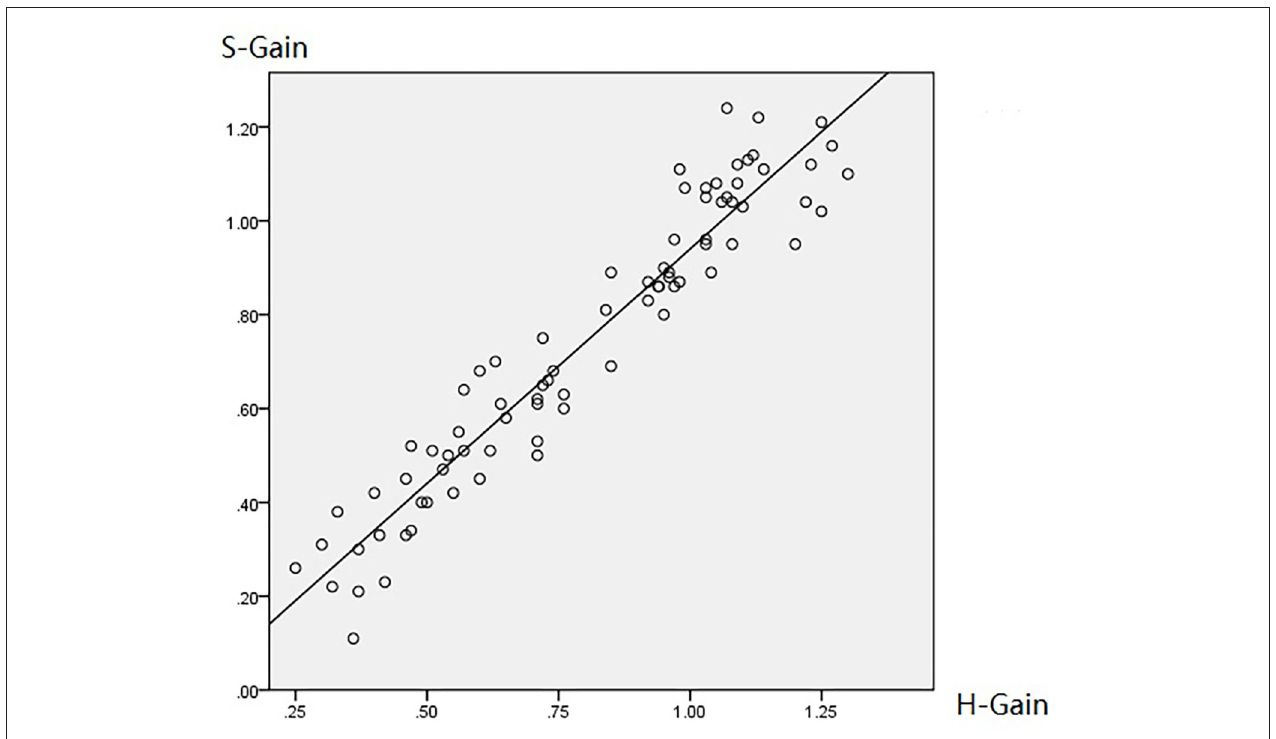
FIGURE 4 | Diagram of HIMP and SHIMP gain correlation. HIMP and SHIMP gain were highly positively correlated ( r = 0.957, p = 0.000; Table 3 ; this